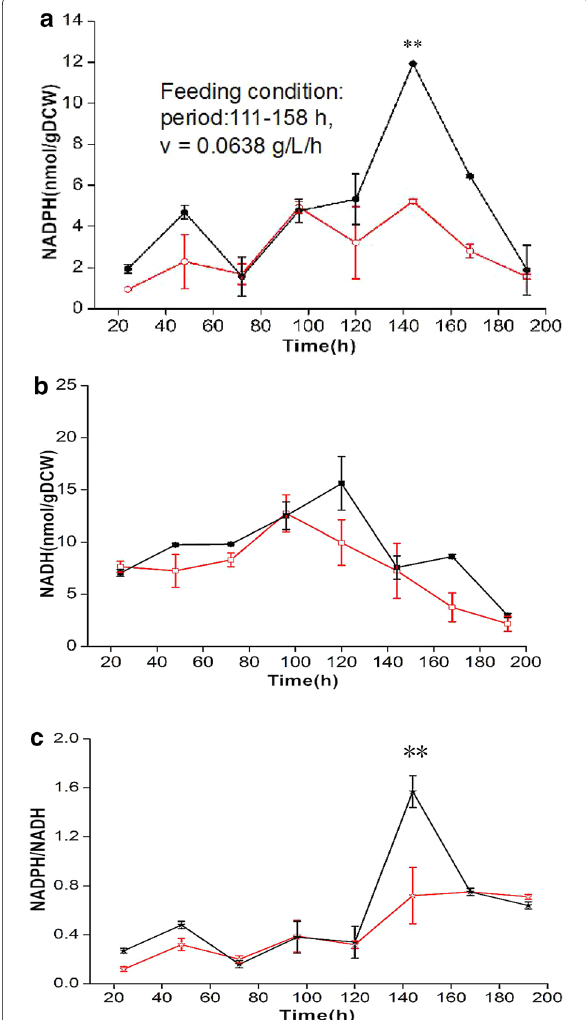
Fig. 5 Time course of intracellular NADPH ( a ) or NADH ( b ) concentrations and their ratio ( c ). Black: mode 8. Red: control. Each point represents the mean ( n 3) standard deviation. **Represents p < = ±